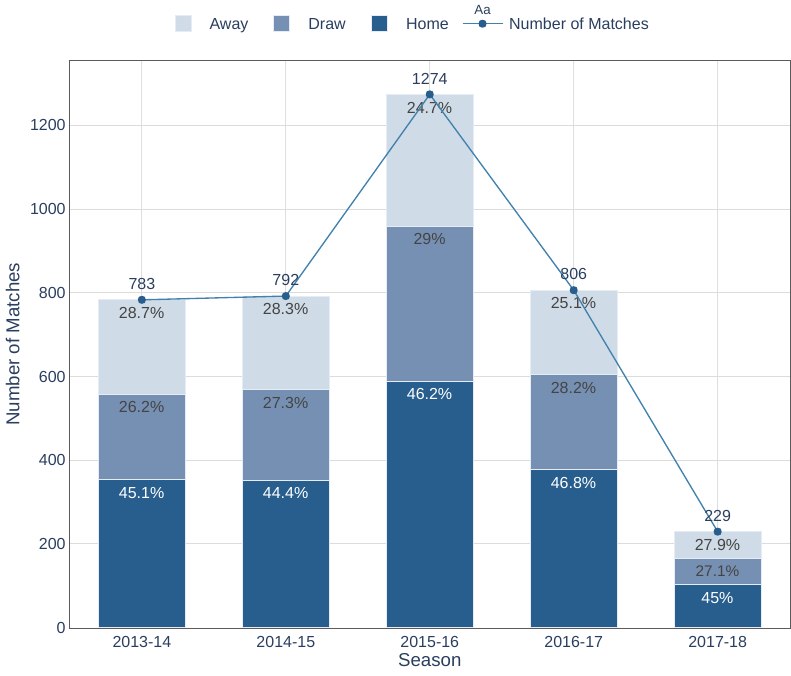
Figure 4. Full time results per